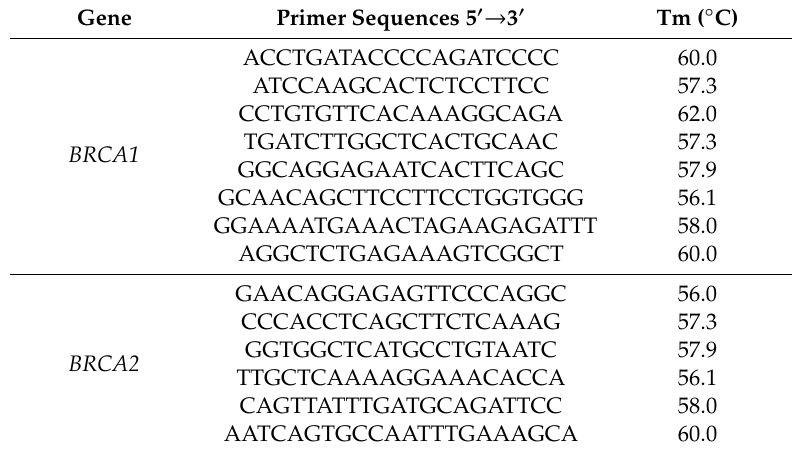
Table 1. Internal primers used for labelling sequences. Primer used in to perform 3 (cid:48) UTR ( BRCA1 and BRCA2 )